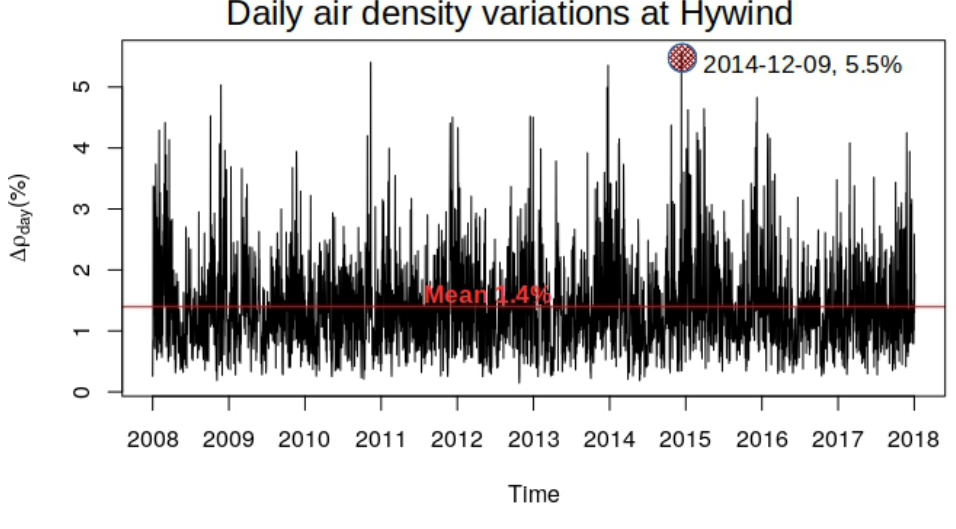
Figure 7. Daily time series of air density variations at